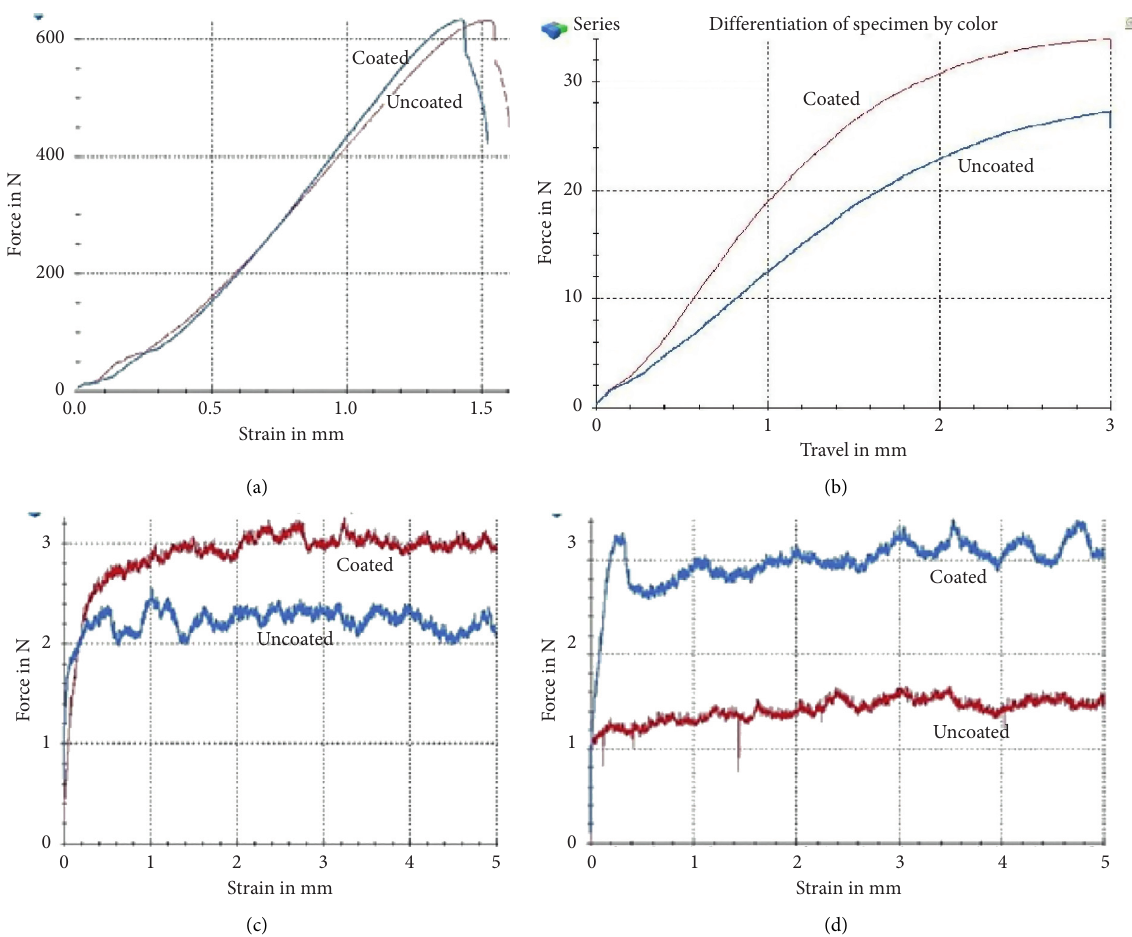
Figure 3: (a) The curve of stress-strain for modulus of elasticity in coated and uncoated wires. (b) Differences of load deflection for coated and uncoated wires. (c) The friction resistance ( N ) for coated and uncoated wires are compared at 0 ° (a) and 10 ° (b)